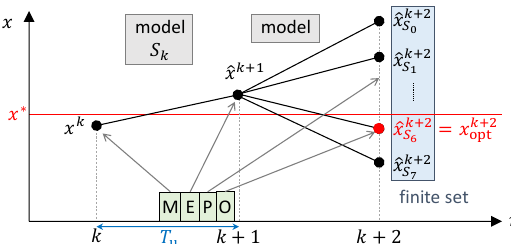
Figure 3. Working principle of FS-MBPC, visualizing the basic steps: measurement (M), estimation (E), prediction (P), and optimization (O).